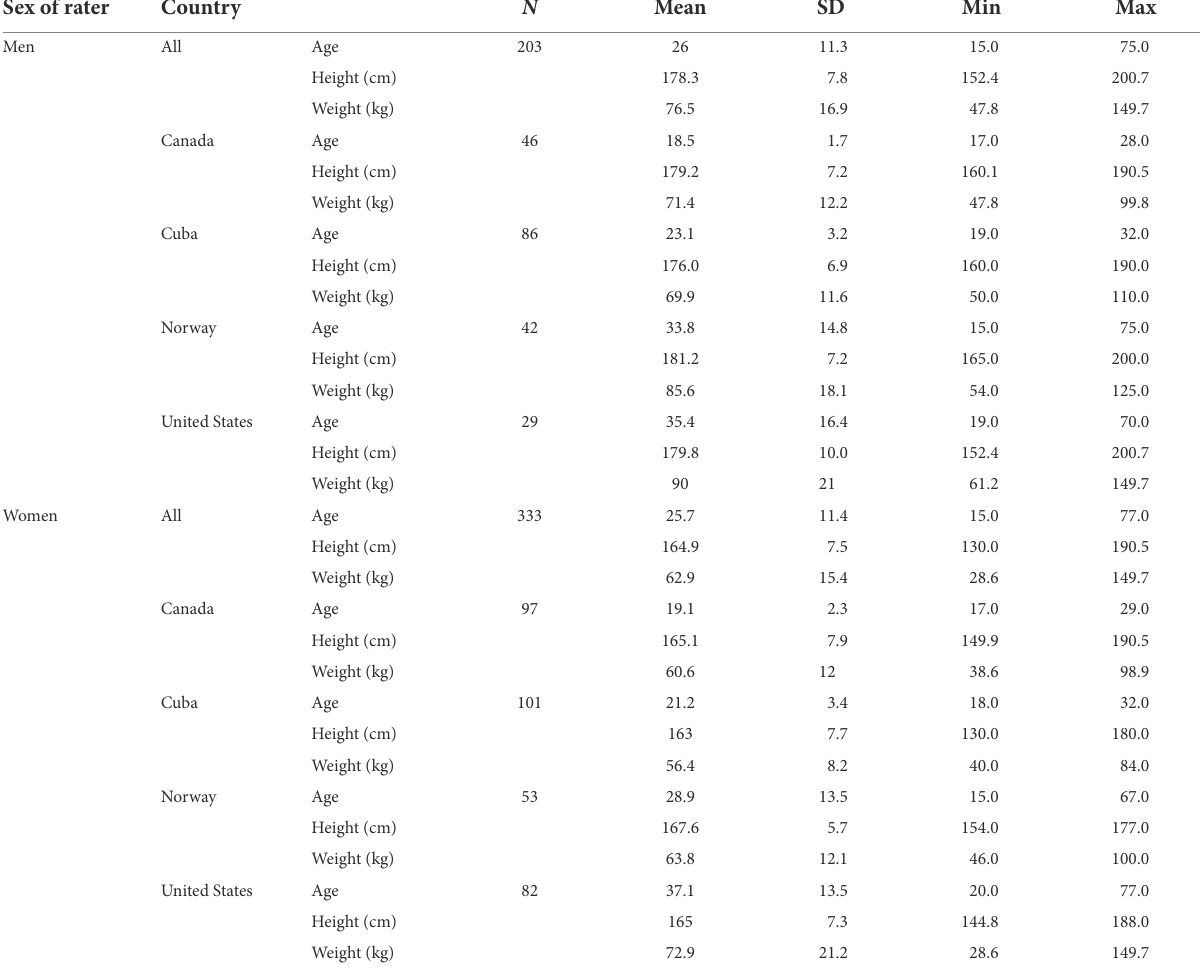
TABLE 1 Descriptive statistics for age, height, and weight of each sample by sex and country. Sex of